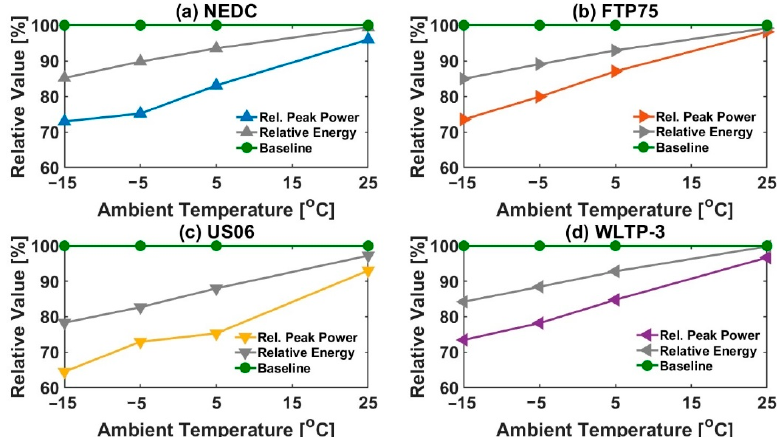
Figure 3. Comparing Relative Peak Power Delivered and Relative Energy Delivered from Cell to Baseline Peak Power and Relative Energy Demanded for Various Ambient Temperatures and Legislative Drive Cycles for 65% starting SOC employing current-based approach: ( a ) NEDC, ( b ) FTP75, ( c ) US06 and ( d ) WLTP (Class 3).